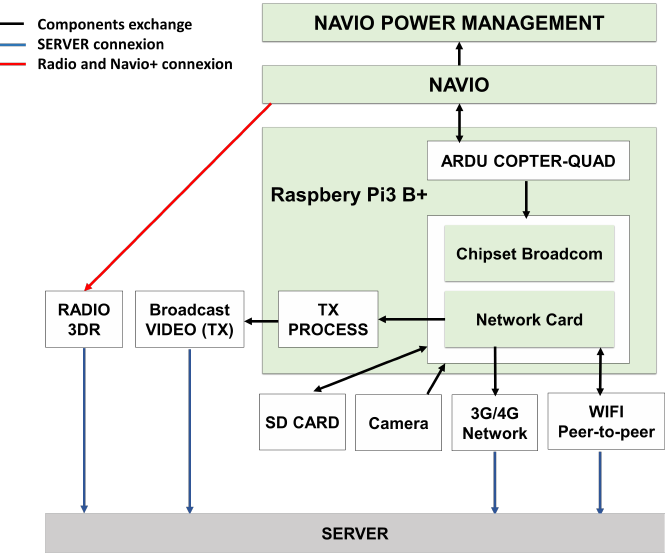
Figure 2. The hardware architecture of VAGADRONE.